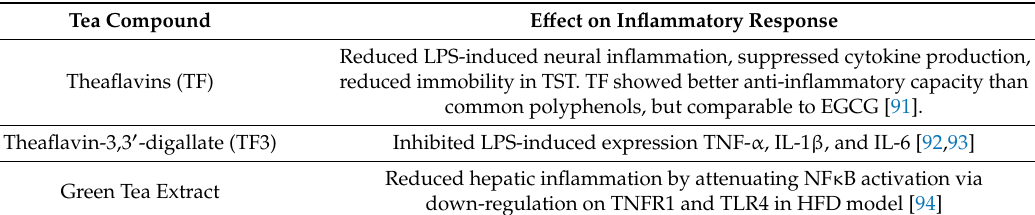
Table 2. Various tea compounds and their anti-inflammatory e ff